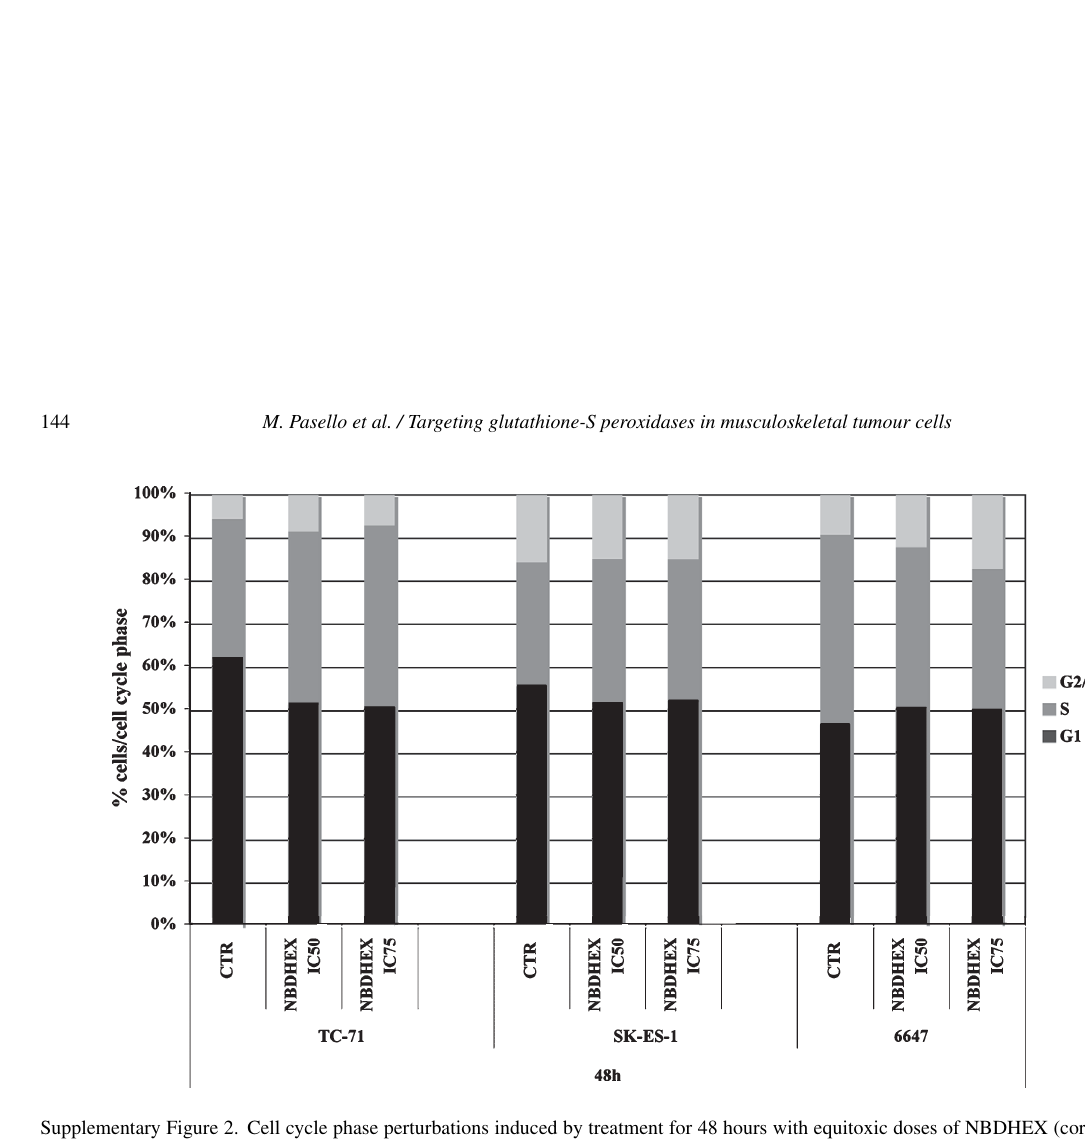
Supplementary Figure 2. Cell cycle phase perturbations induced by treatment for 48 hours with equitoxic doses of NBDHEX (corresponding to the IC50 or IC75 concentration of each cell line) in human Ewing’s sarcoma cell lines. Data refer to the percentage of cells for each cell cycle phase and are representative of at least two different experiments.